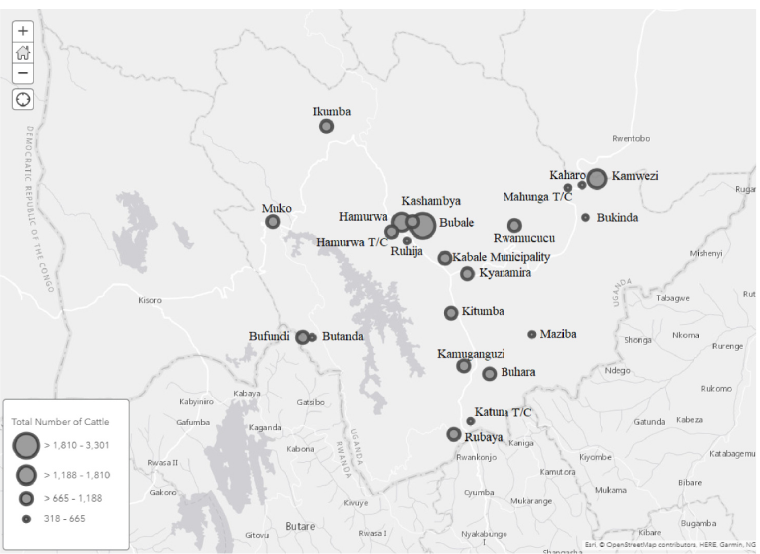
Fig 2. Locations of cattle contact networks in the Kabale District; circles represent center of each location. Circles diameters are scaled to total number of cattle in each location. Bigger size of circle represents greater numbers of cattle within a